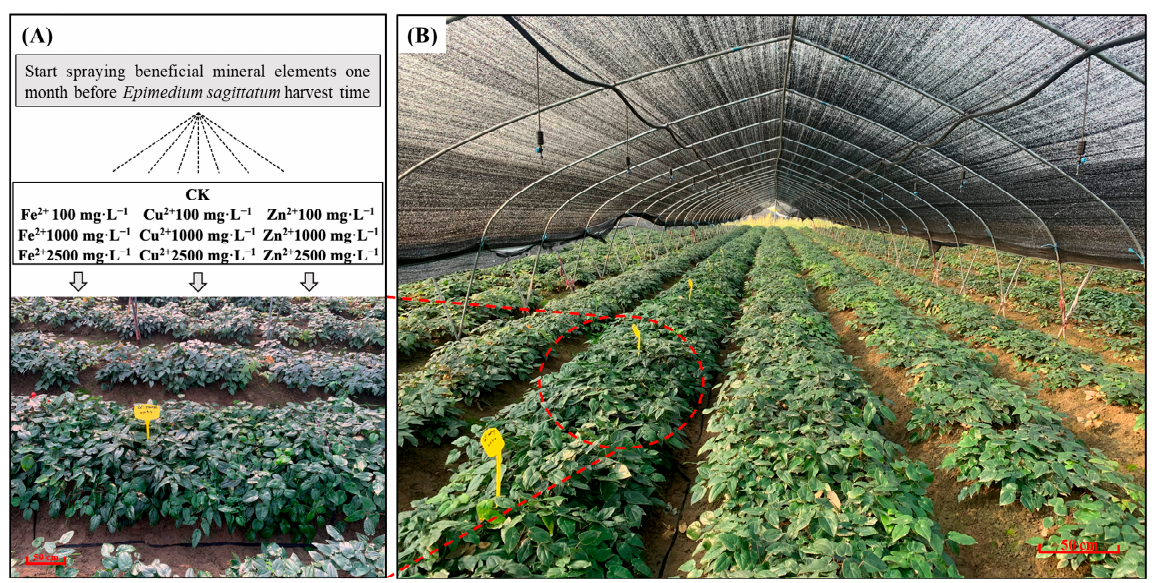
Figure 1. Overview of experimental sites used for spraying mineral elements on E. sagittatum . ( A ) Diagram of the spraying of mineral elements before E. sagittatum harvest. ( B ) The growth situation of E. sagittatum in special cultivation facilities.